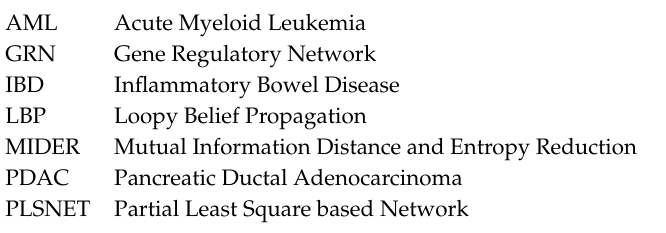
Supplementary Materials: Code can be found at https: // github.com / azizfurqan / PGM. The following are available online at http: // www.mdpi.com / 1422-0067 / 21 / 21 / 7886 / s1. Figure S1: GRN generated from the application of PLSNET on the IBD dataset. Figure S2: The two identified regulators are represented by the largest observed e ff ect size. Figure S3: GRN generated using PLSNET for AML. The threshold value is selected in such a way that the top 10% of all edges are selected. Figure S4: Pearson correlation plots for the AML dataset. Figure S5: GRN generated from the application of MIDER on the DREAM dataset. Figure S6: Pearson correlation plots for the DREAM4. Figure S7: Gene set enrichment results from the IBD dataset. Figure S8: Gene set enrichment results from the PDAC dataset. Table S1: Distribution of the posteriors versus observed experimental states for GSE15471. Table S2: Distribution of the posteriors versus observed experimental states in the AML dataset. Table S3: Distribution of the posteriors versus observed experimental states in the AML dataset. Table S4: Frequencies of di ff erent genes appearing as Regulatory (R), Target (T), or Intermediate (I) genes for di ff erent threshold values in the DREAM4 dataset. Table S5: Distribution of the posteriors versus observed experimental states for